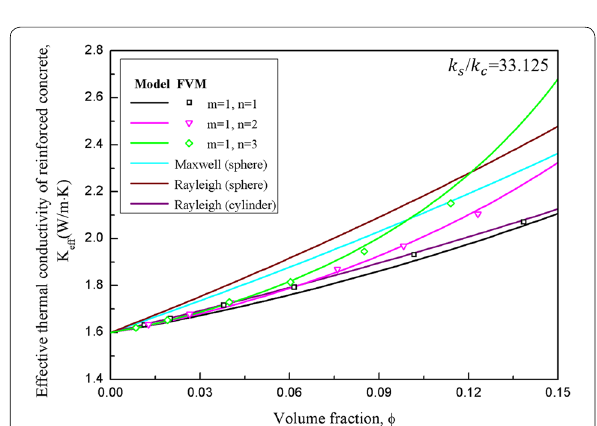
Fig. 10 Effective thermal conductivity of reinforced concrete versus volume fraction at the heat transfer direction.